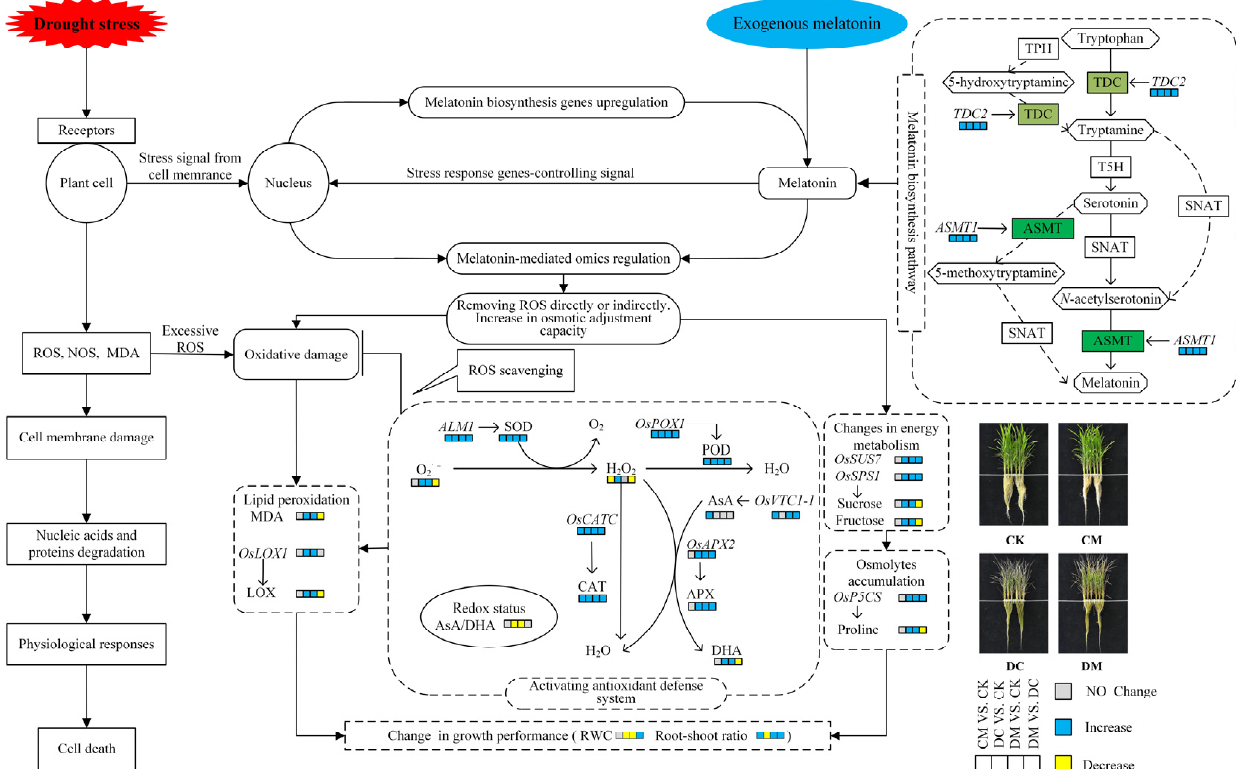
Figure 10. A proposed regulatory model for mitigating the effect of exogenous melatonin on rice seedlings under drought stress. The solid boxes represent the results of the well-documented studies, and the dashed boxes represent the results of this study. The diamond boxes represent substrates, intermediates, and final products in the melatonin synthesis pathway. The boxes represent synthetases, and the colored boxes represent two rate-limiting synthetases encoded by TDC2 and ASMT1 in this study.